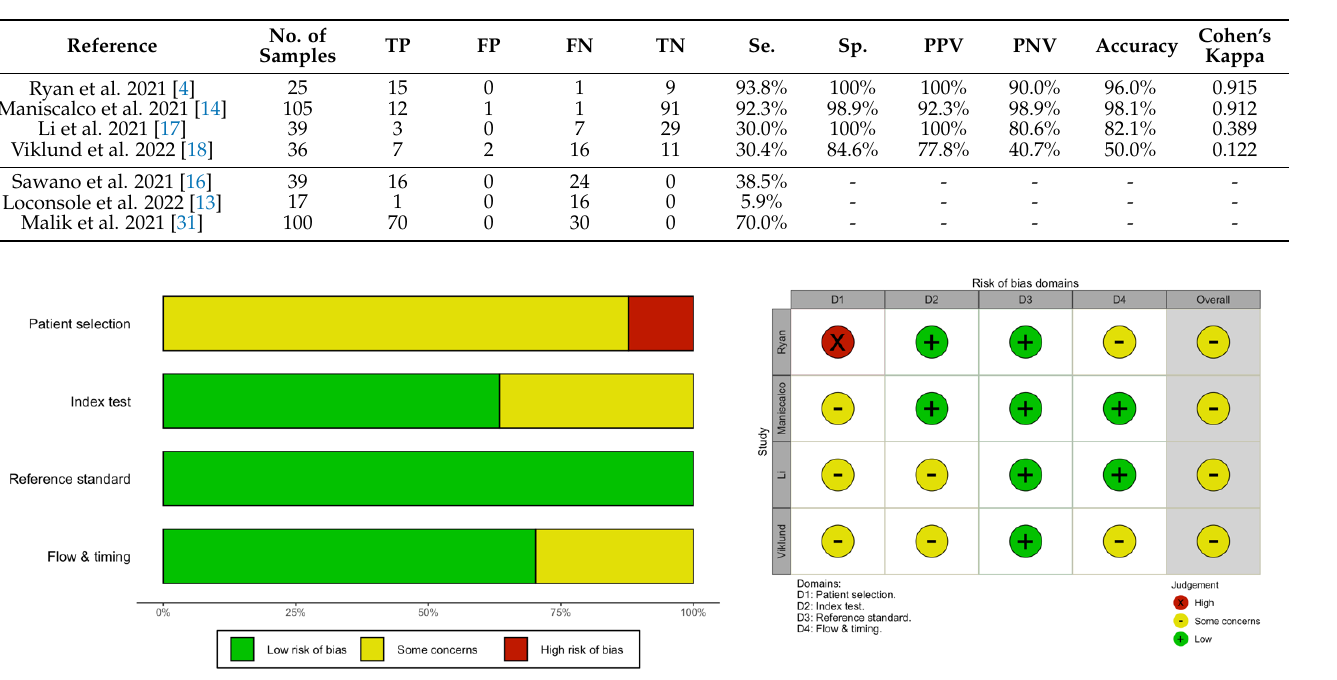
Table 4. A summary of the diagnostic performances of the RT-qPCR performed on EBC compared to conventional tests on nasal swabs that were included in the systematic review (note: DOR = diagnostic odds ratio; 95%CI = 95% confidence intervals).